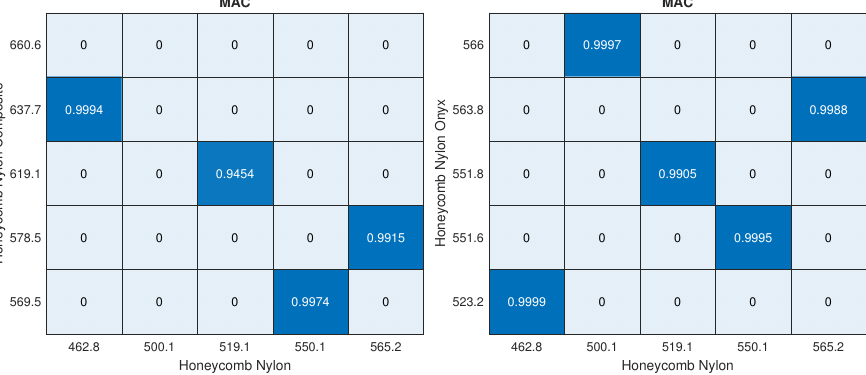
Figure 7. MAC results of honeycomb lattice structure: Free–free. Table 3. First five natural frequencies of the honeycomb lattice structure in the free–free boundary condition and the paired modes when the material of vertical parts of honeycomb lattice structure changed to composite or onyx.